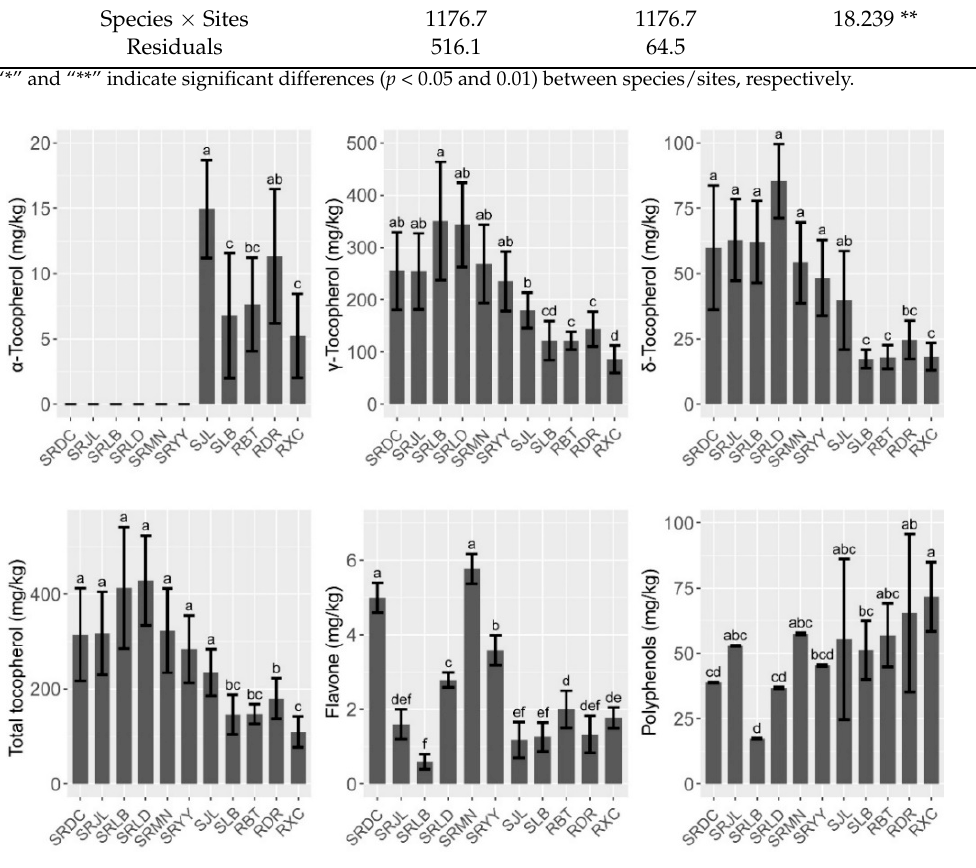
Figure 3. Micronutrient and secondary metabolites composition and contents of walnut oils. different letters indicate significant differences ( p ˂ 0.05) between different species/sites. Table 3. Two-way analysis of variance (two-way ANOVA) of the micronutrients and secondary metabolites.